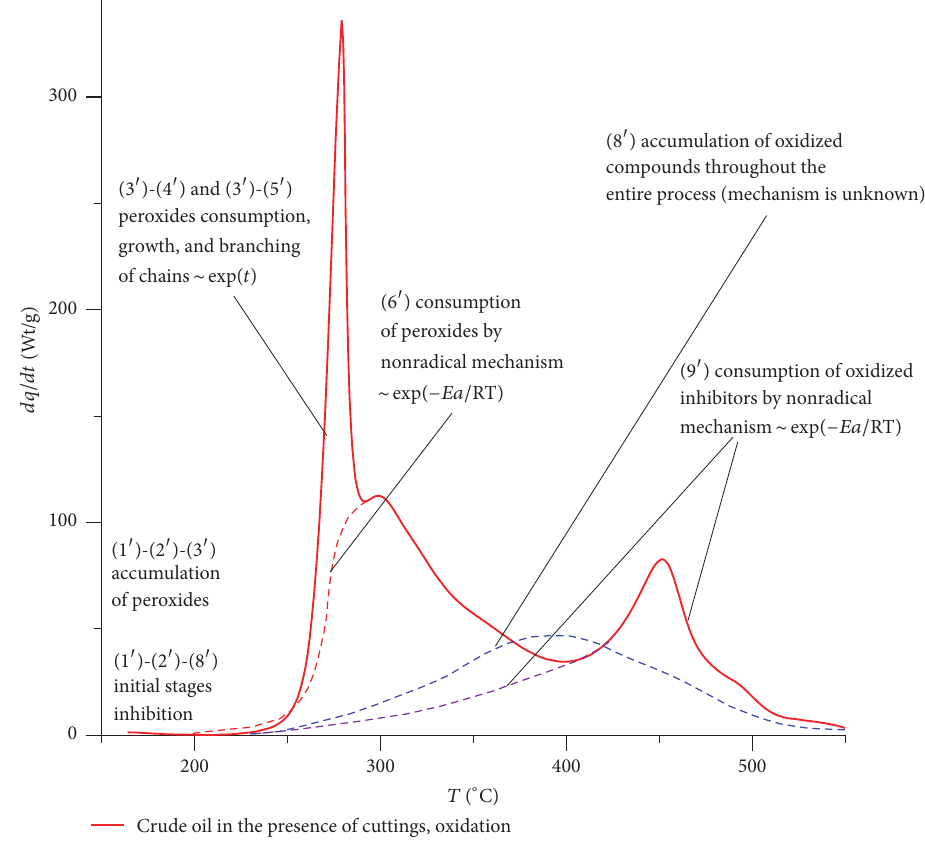
Figure 8: Distribution of examined oxidation processes according to heat release curve on the